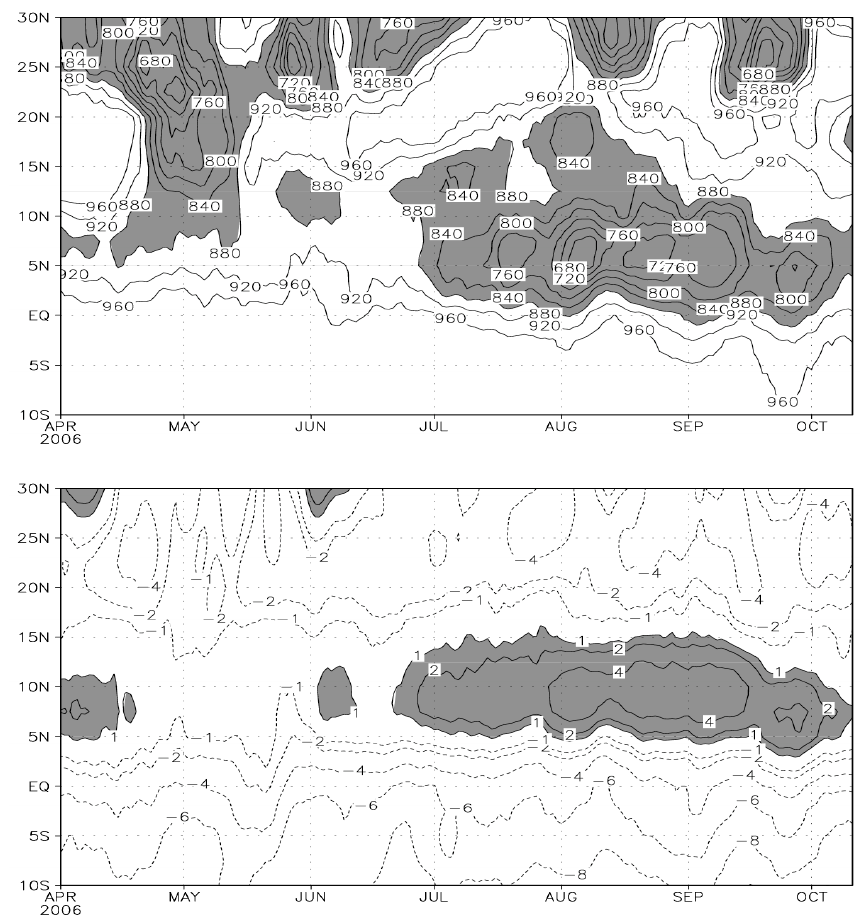
Figure 9. Top: Averaged 10°W-10°E time-latitude evolution of the pressure level of the top of the monsoon layer (hPa) estimated by the level where the mean NCEP zonal wind component equals zero from westerly winds below to easterly winds above. Grey areas for levels lower than 880 hPa. Bottom : Averaged 25°W-15°W 925 hPa zonal wind time-latitude evolution. A 11-day moving average has been applied. Grey areas for zonal winds higher than 1 ms -1 .